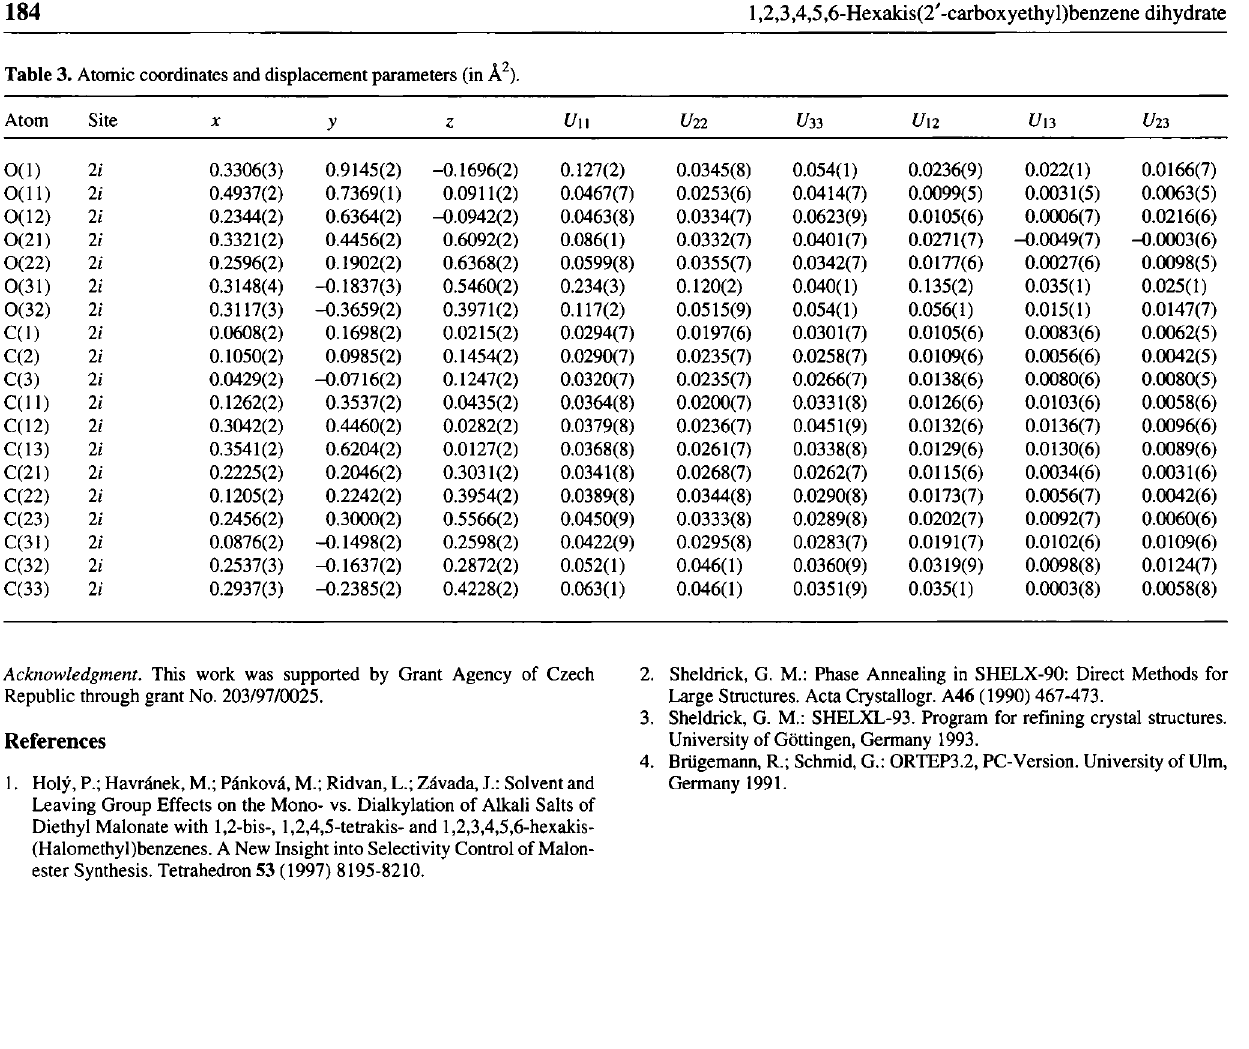
Table 3. Atomic coordinates and displacement parameters (in Ä 2